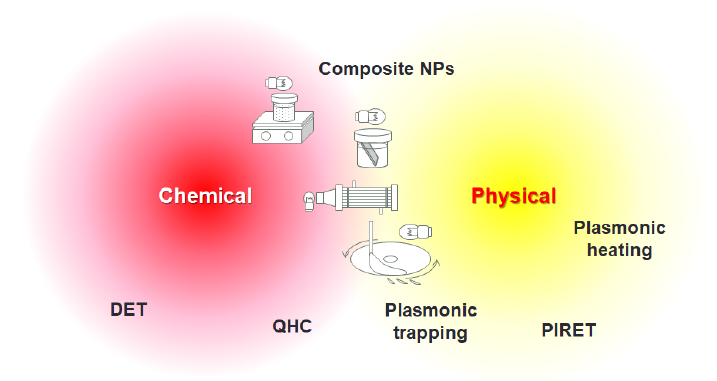
Figure 6. Chemically and physically plasmonic enhancement models of various types of energy transformation in plasmonic photocatalytic